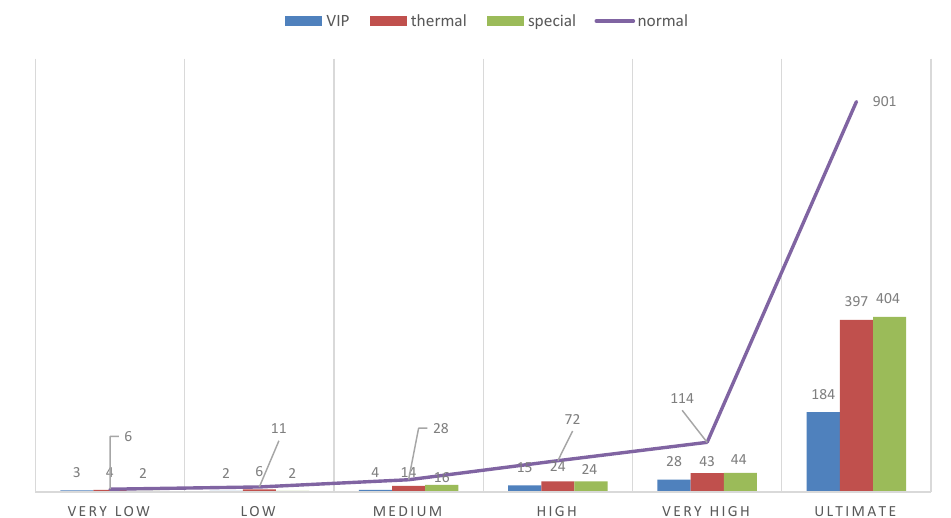
Figure 15. Six simulation modes. (The numbers mean the number of people handled in the particular types of queues plus people who were in the queues at the time of the simulation